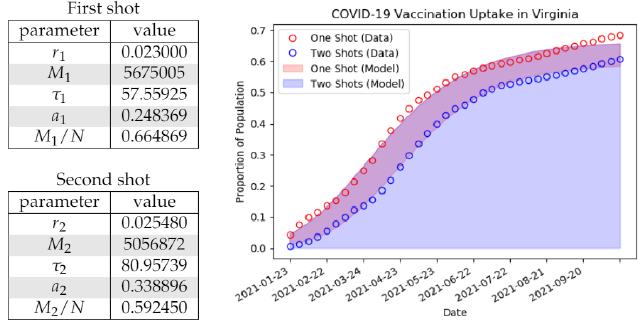
Figure 1. On the left, we indicate the best fit parameters for the generalized logistic curve or Richards’ curve (4) to Virginia Department of Health data [25] on vaccination uptake starting with t = 0 corresponding to 23 January 2021. The values M 1 / N and M 2 / N correspond to the saturation proportions for the first and second doses, respectively (i.e., the number of willing/able vaccine recipients). We use the population denominator N = 8,535,519 corresponding to the population of Virginia. On the right, we display the model fit (solid) to the observed data (circles).